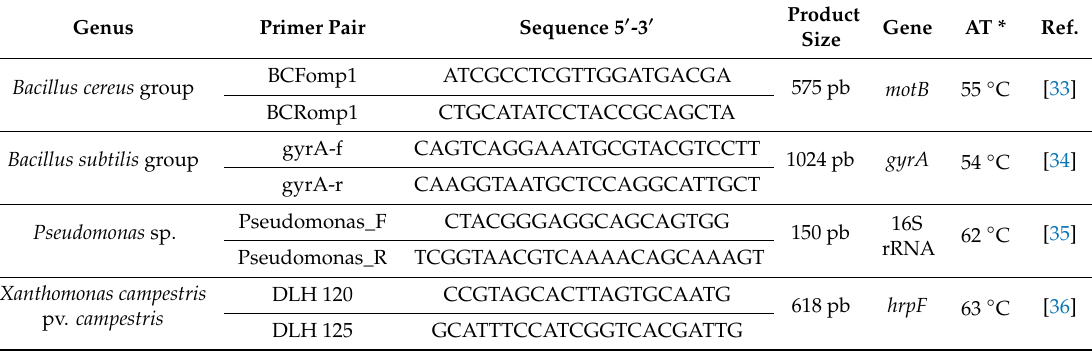
Table 1. Specific primer pairs used for identification of the four targeted bacterial